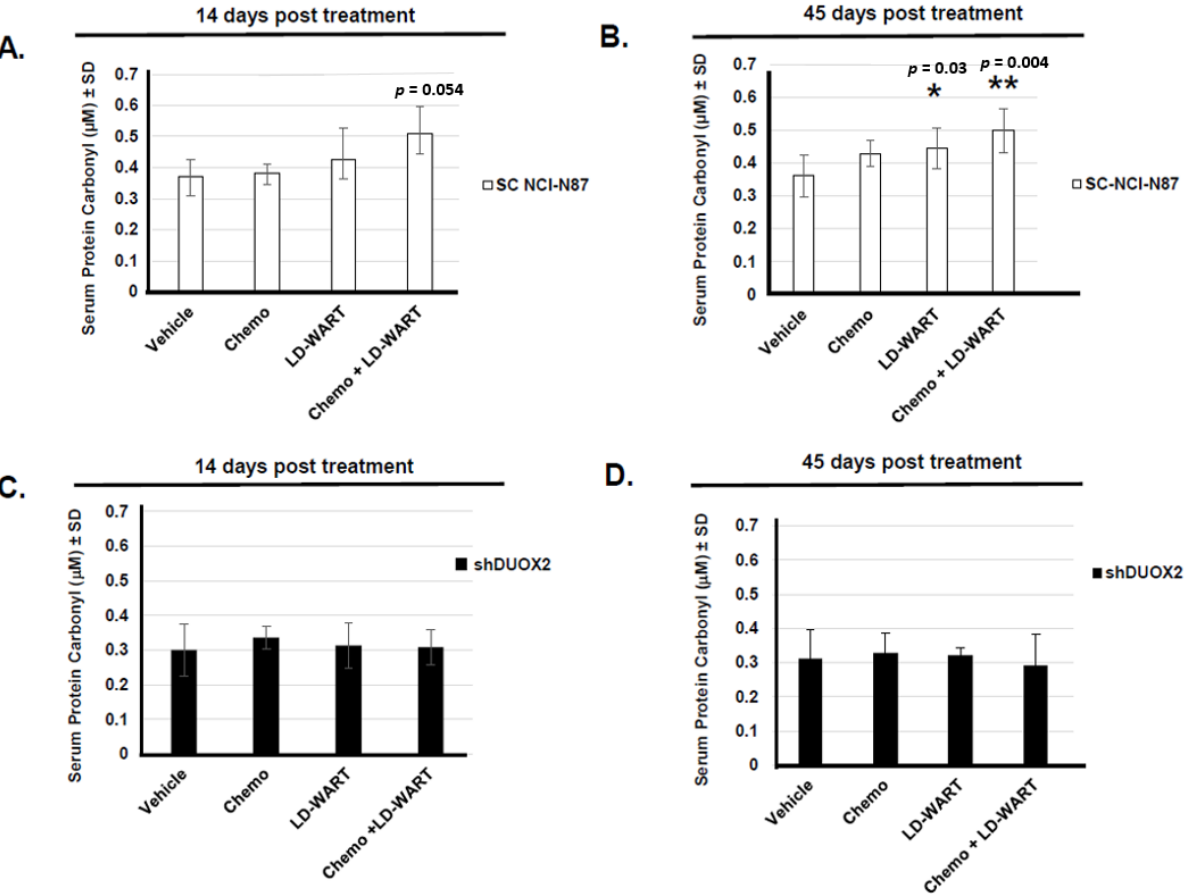
Figure 3. DUOX2 activity in vivo. ( A , B ) Serum protein carbonyl content from serum of mice bearing tumors expressing endogenous (scrambled, white boxes) DUOX2 levels at 14 ( A ) or 45 ( B ) days post end of the indicated treatments ( n = 7–8 mice). ( C , D ) Same as ( A ), ( B ) except that serum was obtained from mice bearing tumors expressing reduced DUOX2 levels (shDUOX2, black boxes). n = 6–8 mice. Data are compared to serum from untreated (Vehicle) mice. Data were evaluated by 1 way ANOVA with Dunnett’s multiple comparison test. * p < 0.05, ** p < 0.005. p <0.05 is considered significant.